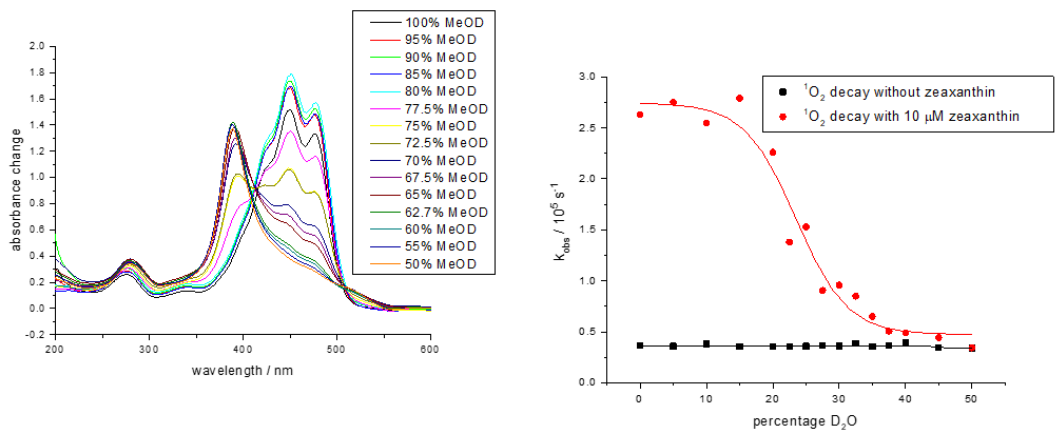
Figure 4. Left: ground state absorption spectra of 1 × 10 − 5 M zeaxanthin in various MeOD / D 2 O mixtures. Right: the effect of increasing D 2 O (inducing zeaxanthin aggregation) on 1 O 2 deactivation efficiency of zeaxanthin.